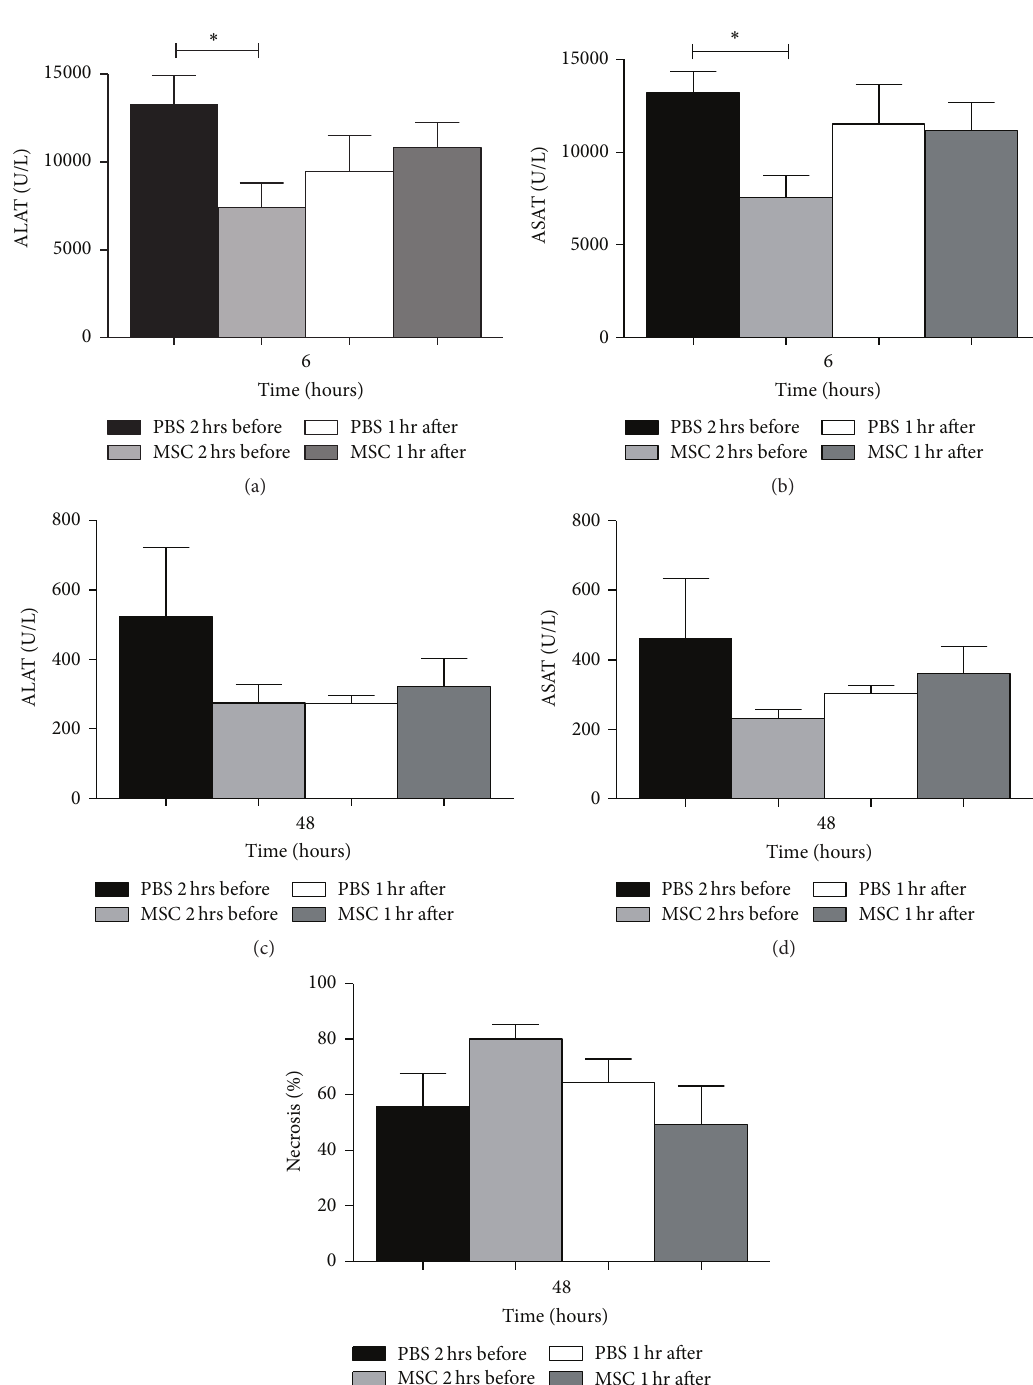
Figure 1: Hepatocellulair injury. (a) Six hours after IRI and PH, the serum ALAT concentration was significantly lower in mice treated with MSC 2 hours before hepatic IRI and PH compared to their PBS control. (b) Serum ASAT concentration, six hours after reperfusion, was significantly lower in mice treated with MSC 2 hours before IRI and PH compared to their PBS controls. (c) Forty-eight hours after IRI and PH there were no significant differences in serum ALAT levels between mice treated with MSC or PBS. (d) Serum ASAT concentrations showed no significant differences forty-eight hours after IRI and PH between mice infused with MSC or PBS. (e) Forty-eight hours after IRI and PH, livers from mice treated with MSC showed no differences in amount of necrosis compared to their PBS controls. The data are expressed as means ± SEM (( ∗ 𝑃 < 0.05 ) versus their PBS